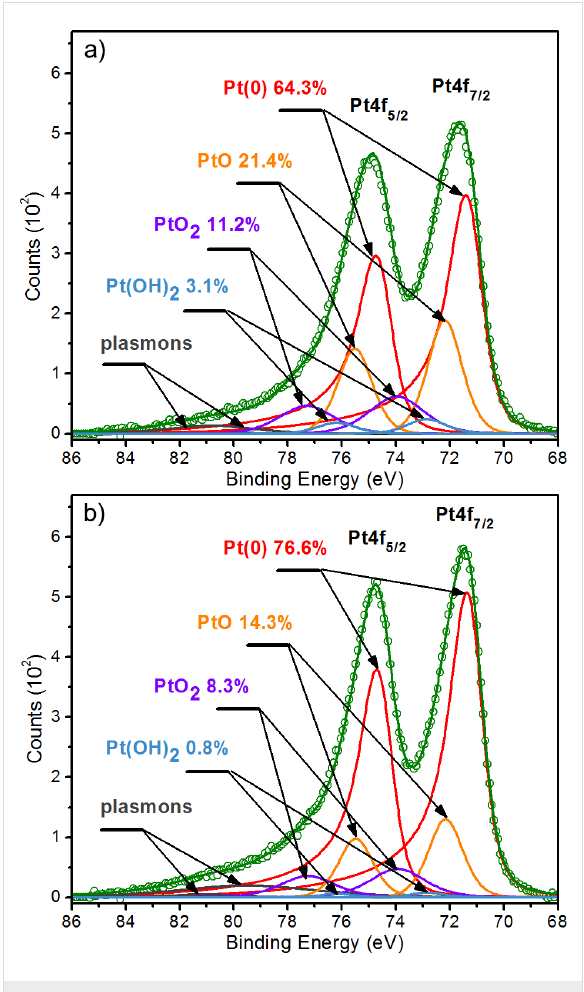
Figure 4: High-resolution XPS spectra of the Pt 4f band for (a) refer- ence catalyst 20% Pt XC-72R and (b) sample A prepared using PLD characterized by a similar Pt-to-C ratio determined from XPS measure-